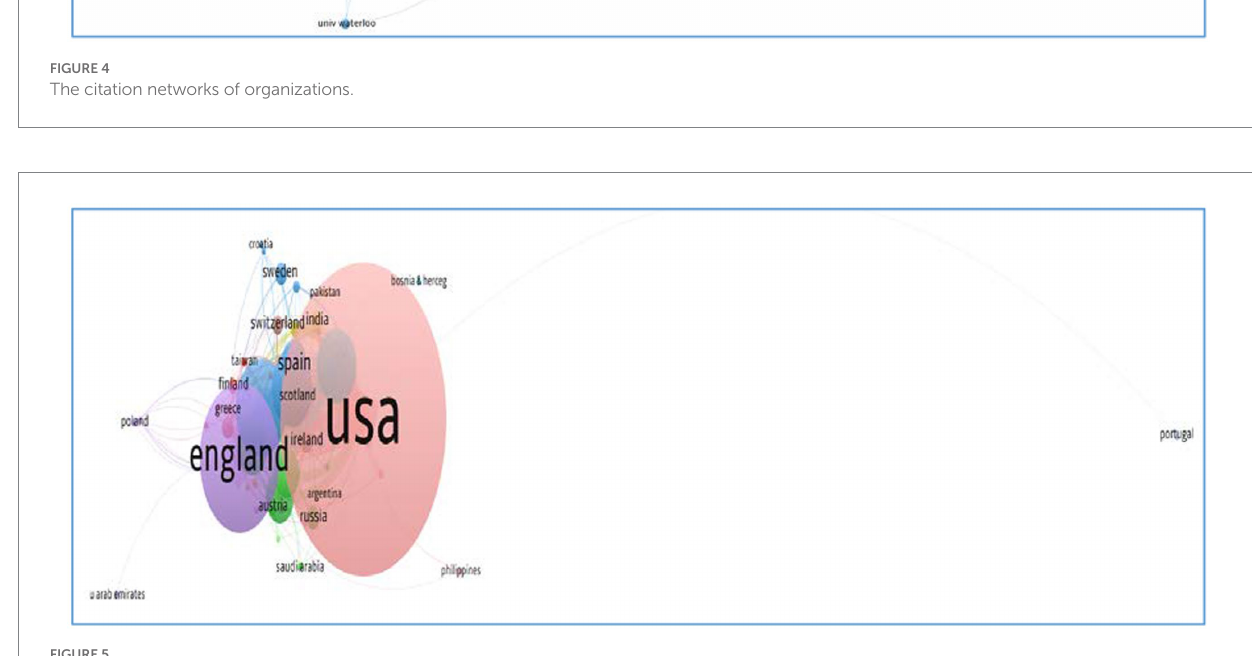
FIGURE 5 The citation networks of